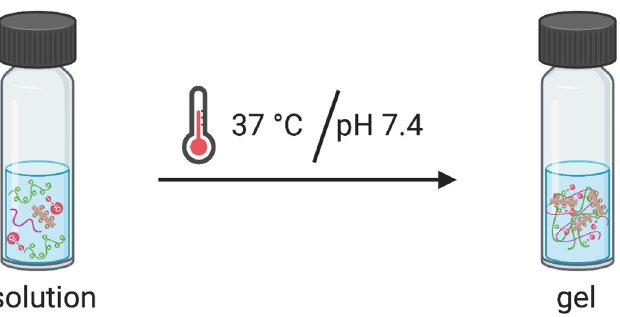
Figure 1. Schematic illustration of sol-gel transition and polymer crosslinking behavior under physiological conditions at 37 °C and pH 7.4.